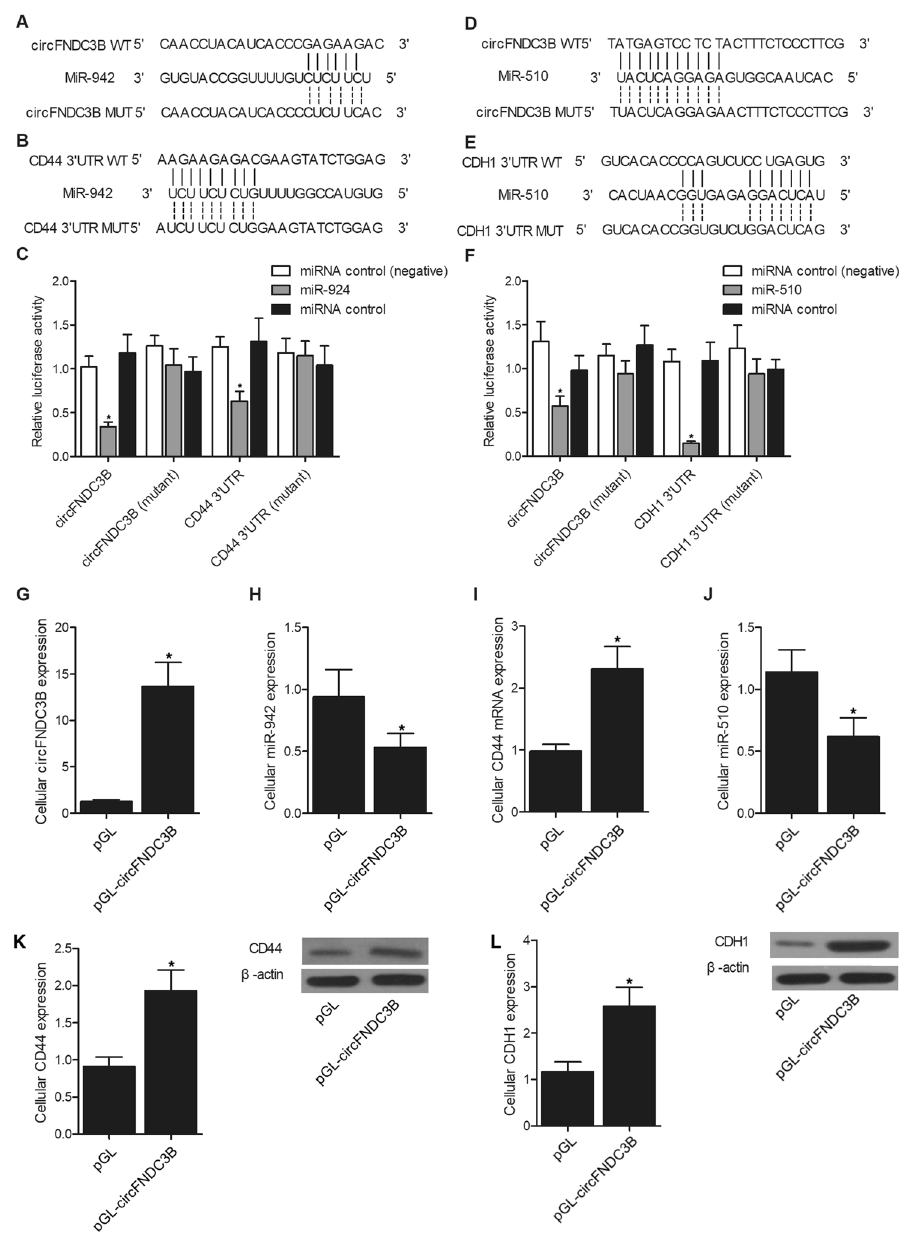
Figure 2. Signaling pathway establishment. ( A ) Sequence comparison between circFNDC2B and miR-942; ( B ) Sequence comparison between CD44 mRNA and miR-942; ( C ) Luciferase activity of wild type circFNDC2B and wild type CD44 mRNA was both evidently reduced in the presence of miR-942 (* P value < 0.05 vs. miRNA control (negative) group); ( D ) Sequence comparison between circFNDC2B and miR-510; ( E ) Sequence comparison between CHD1 mRNA and miR-510; ( F ) Luciferase activity of wild type circFNDC2B and wild type CHD1 mRNA was both evidently reduced in the presence of miR-942 (* P value < 0.05 vs. miRNA control (negative) group); ( G ) CircFNDC3B expression was elevated in MKN28 cells overexpressing circFNDC3B (* P value < 0.05 vs. pGL group); ( H ) MiR-942 expression was inhibited in MKN28 cells overexpressing circFNDC3B (*P value < 0.05 vs. pGL group); ( I ) CD44 mRNA expression was promoted in MKN28 cells overexpressing circFNDC3B (* P value < 0.05 vs. pGL group); ( J ) MiR-510 expression was up-regulated in MKN28 cells overexpressing circFNDC3B (* P value < 0.05 vs. pGL group); ( K ) CD44 expression was higher in MKN28 cells overexpressing circFNDC3B (* P value < 0.05 vs. pGL group); ( L ) CDH1 expression was higher in MKN28 cells overexpressing circFNDC3B (* P value < 0.05 vs. pGL